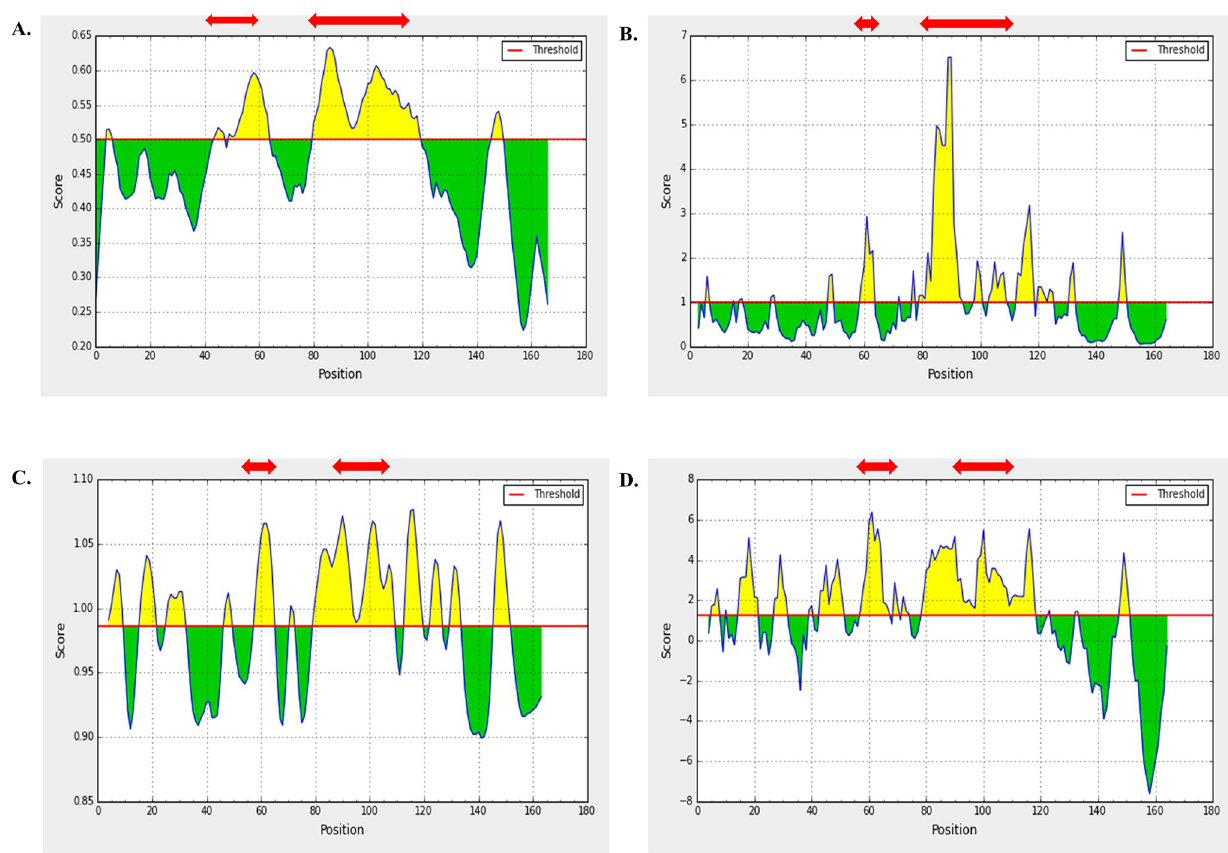
Fig 2. B cell Epitope prediction of prM protein at IEDB linear epitope prediction tool. Predicted peptide regions above the threshold values (yellow region) are shown in red arrow. Methods used for prediction are enlisted as: (A) BepiPred 2.0, (B) Emini Surface Accessibility tool, (C) Karplus & Schulz Flexibility tool, and (D) Parker Hydrophilicity